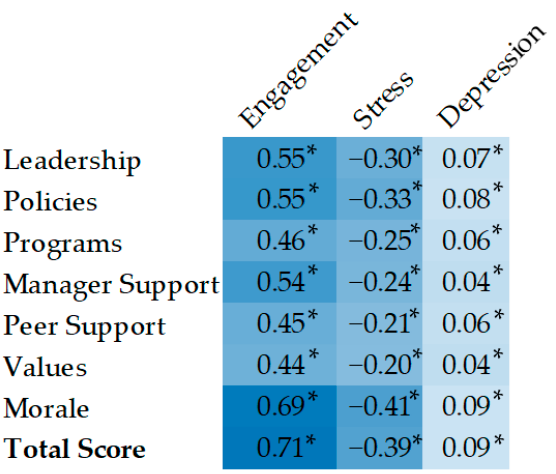
Figure 1. Correlations by Workplace COH subscales and work engagement, stress, and depression. Note: * denotes correlation coefficient was significant at p < 0.001.